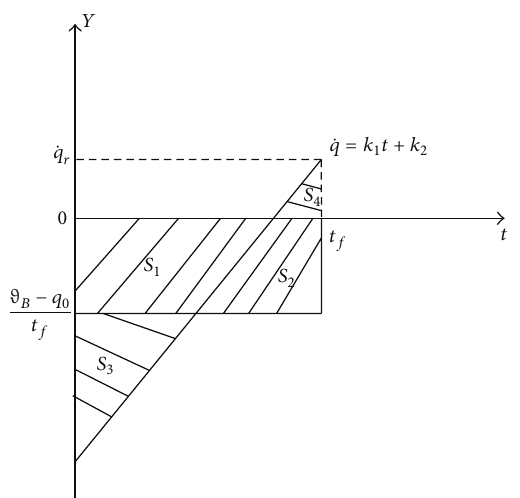
Figure 9: LOS angle rate equation designed by the first-order equa- tion.